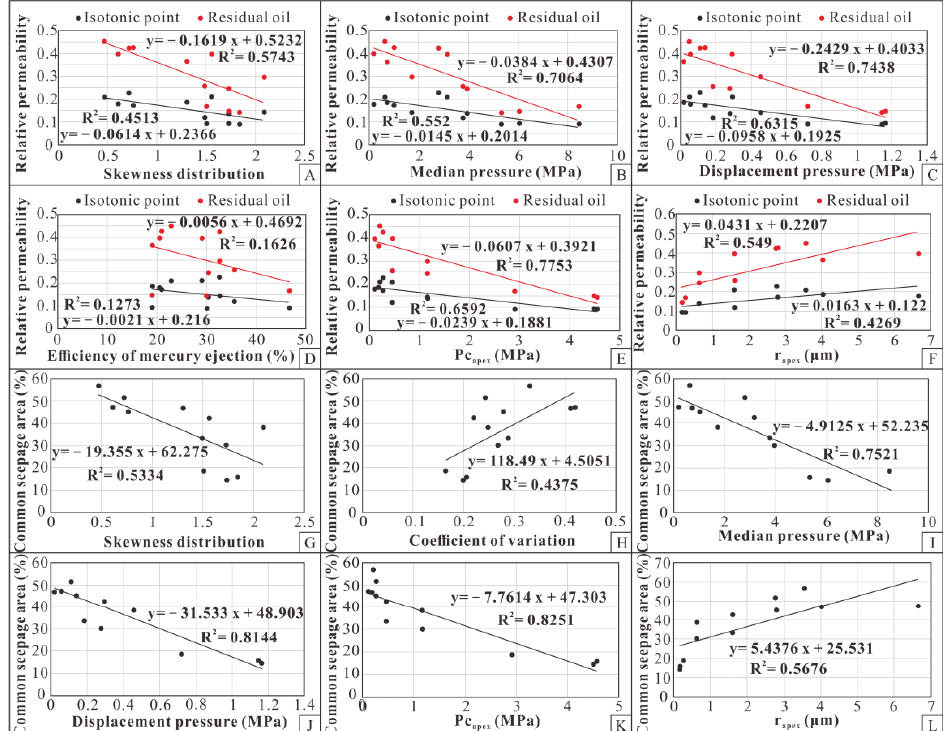
Figure 23. Correlation between pore-throat structure parameters and oil–water relative permeability parameters. ( A ) Correlation between skewness distribution and relative permeability. ( B ) Correlation between median pressure and relative permeability. ( C ) Correlation between displacement pressure and relative permeability. ( D ) Correlation between efficiency of mercury ejection and relative permeability. ( E ) Correlation between Pc apex and relative permeability. ( F ) Correlation between r apex and relative permeability. ( G ) Correlation between skewness distribution and common seepage area. ( H ) Correlation between coefficient of variation and common seepage area. ( I ) Correlation between median pressure and common seepage area. ( J ) Correlation between displacement pressure and common seepage area. ( K ) Correlation between Pc apex and common seepage area. ( L ) Correlation between r apex and common seepage area. Minerals 2022 , 12 , 1243